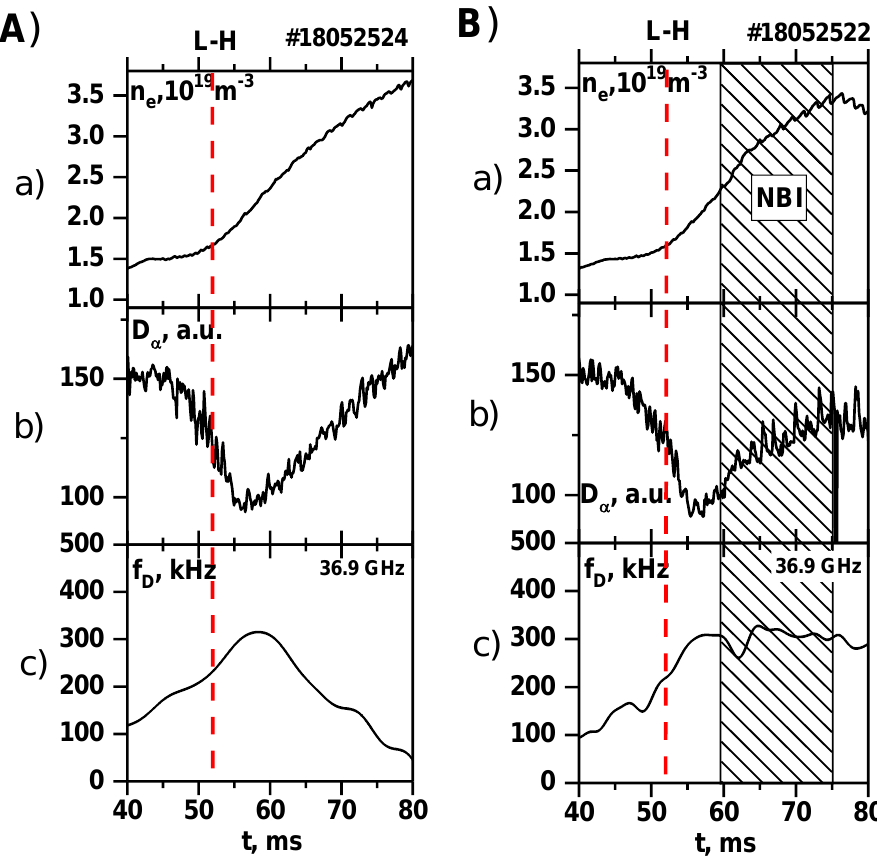
Figure 7. Plasma parameters during TUMAN-3M discharges with a transition to H-mode: ( a ) electron density n e , ( b ) D α signal, ( c ) Doppler frequency shift f D . Red, dashed line at 52 ms indicates the L–H transition. ( A ) NBI not introduced; ( B ) NBI introduced to the plasma at 60 ms (after the transition to H-mode) is indicated by a striped box.